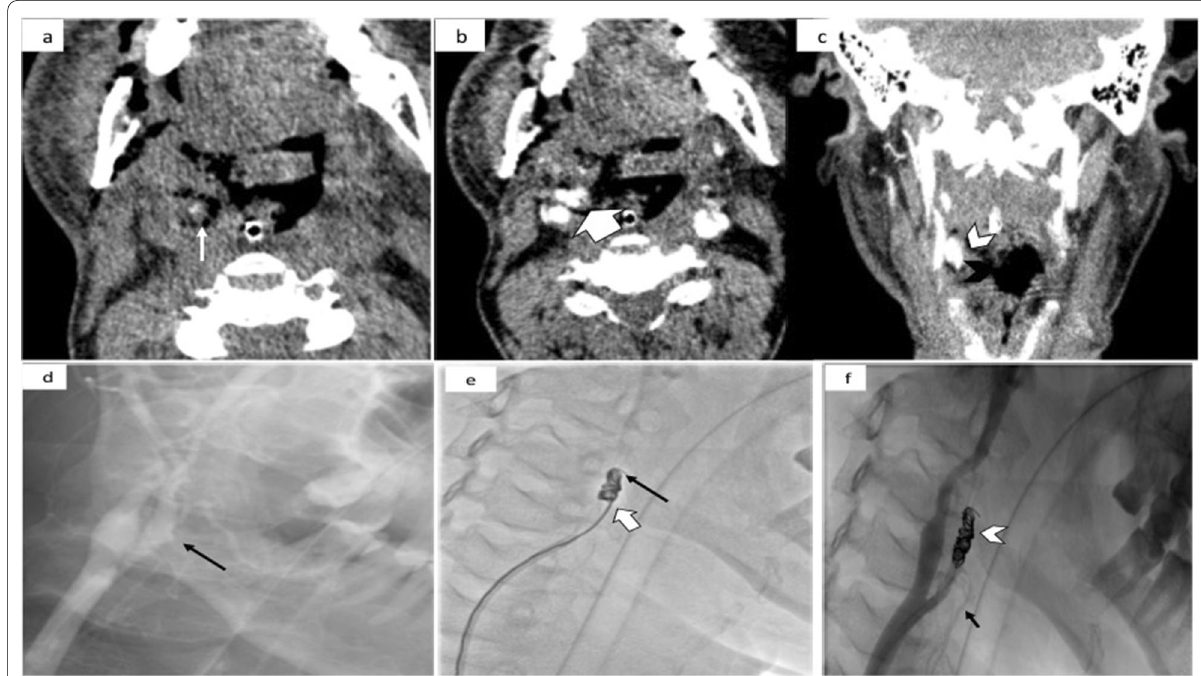
Fig. 4 Computed tomography of patient after stabilization a axial non-contrast section demonstrates soft tissue with air foci at the suspected site of external carotid artery breech (arrow). b Axial section angiography shows the presence of contrast extravasation (open arrow) and persistence of contrast in delayed image s(not shown here). c Coronal CT angiogram shows the presence of contrast extravasation adjacent to right external carotid artery (arrowhead). Endovascular treatment of ECA blowout. Digital subtraction angiography of the same patient. d